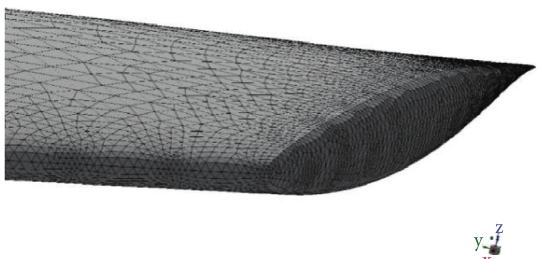
Figure 8: Details of the meshing lead edge of the wing.